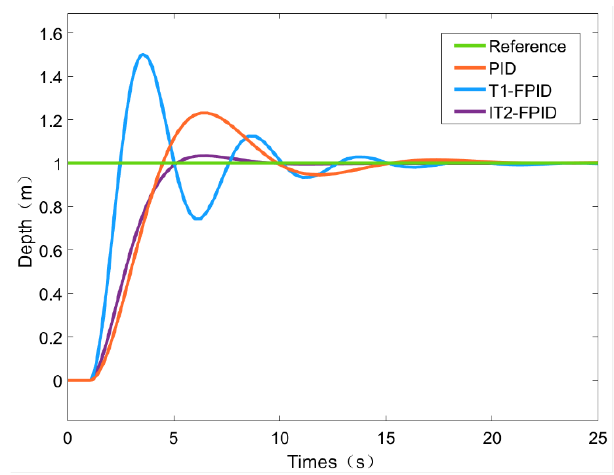
Figure 8. Step response results regarding depth.